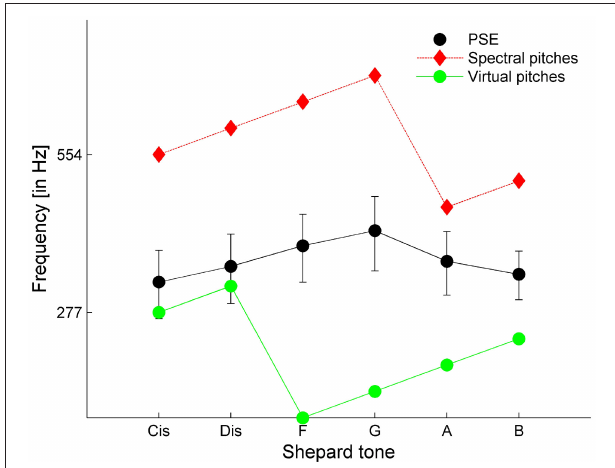
FIGURE 6 | Averaged PSE estimates compared to the spectral and virtual pitches with the highest weight predicted by the VPT. Error bars represent the standard error ( n =